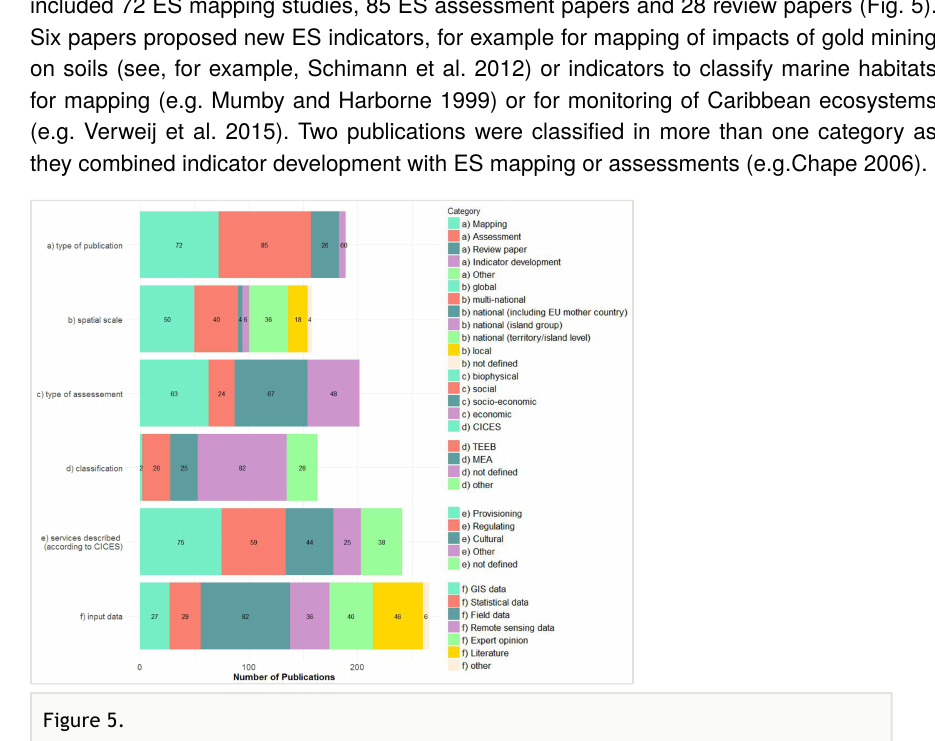
Overview of the individual literature review data variables for Europes ORs and